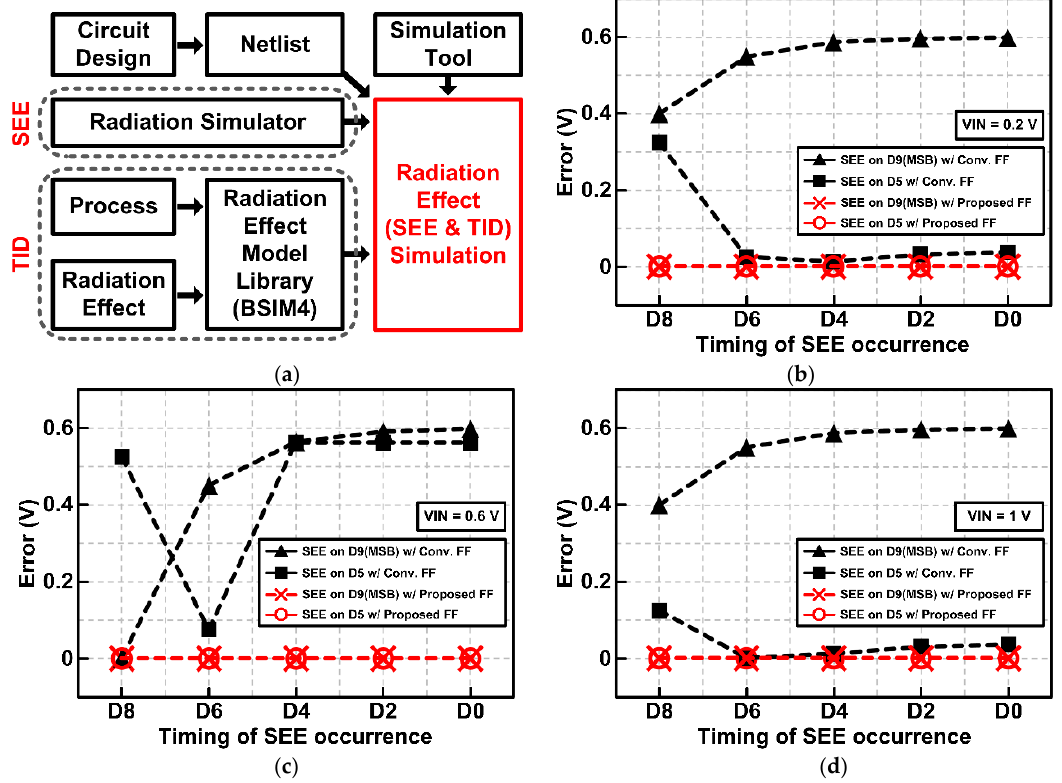
Figure 14. ( a ) Block diagram of the radiation effect simulation process. ( b ) SEE simulation results of the radiation-hardened SAR ADC with proposed flip-flops when V IN is 0.2 V. ( c ) SEE simulation results when V IN is 0.6 V. ( d ) SEE simulation results when V IN is 1 V.